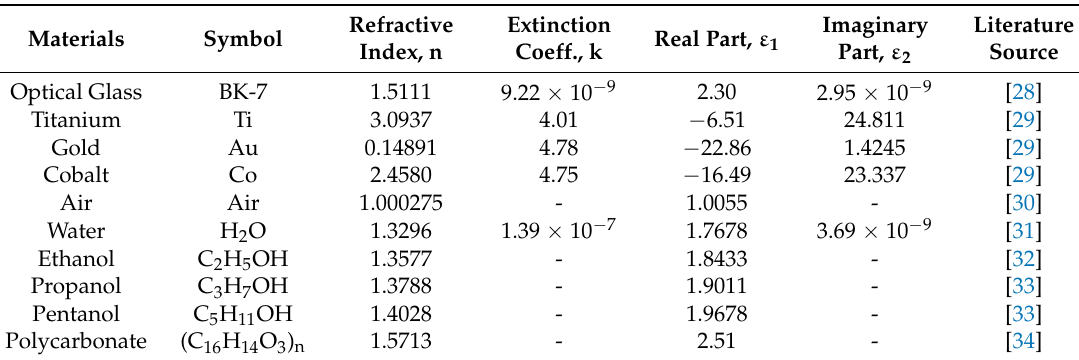
Table 2. Optical parameters at λ = 785 nm used for modeling.  moCo is the complex magneto-optic constant of Co, also known as off-diagonal tensor component (  moCo = −0.85 + j0.0006 at λ = 785 nm), obtained from a past paper [5].